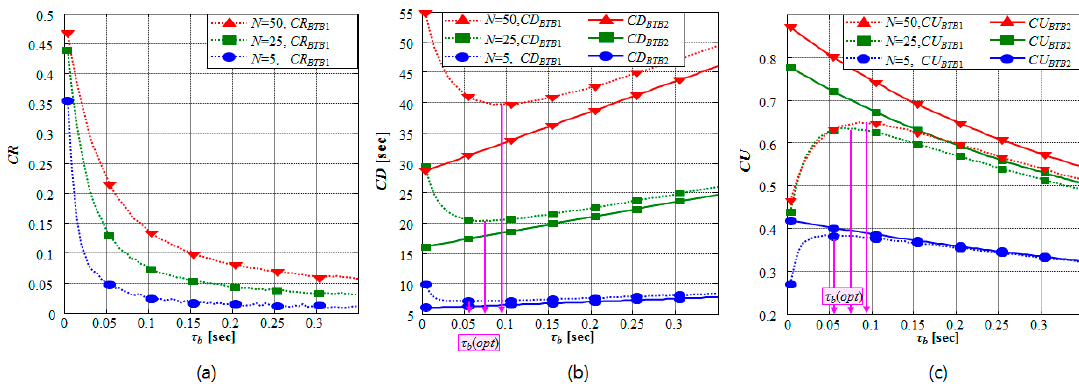
Figure 7. Performances of the BTB-TDMA1 and the BTB-TDMA2 versus the length of a time block at 5 nodes, 25 nodes, and 50 nodes when the network range is 1500 m and the maximum speed of nodes is 5 m/s. ( a ) The CR of the BTB-TDMA1; ( b ) the CD of the BTB-TDMA1 and the BTB-TDMA2; ( c ) the CU of the BTB-TDMA1 and the BTB-TDMA2.